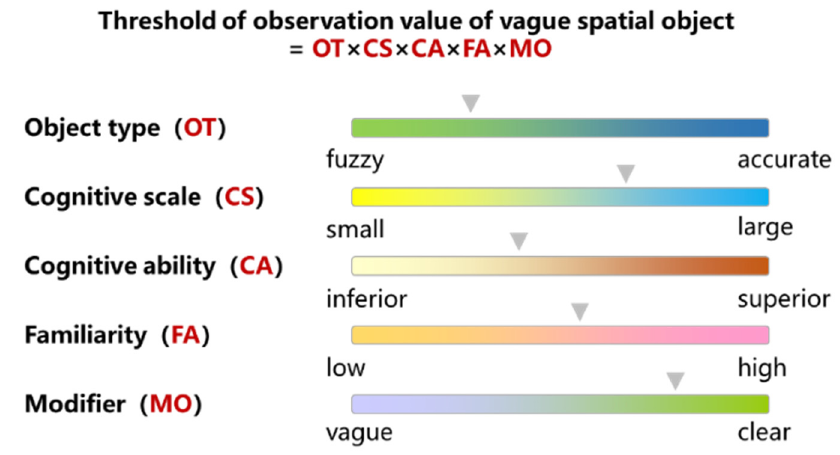
Figure 3. Threshold of observations of vague spatial object.